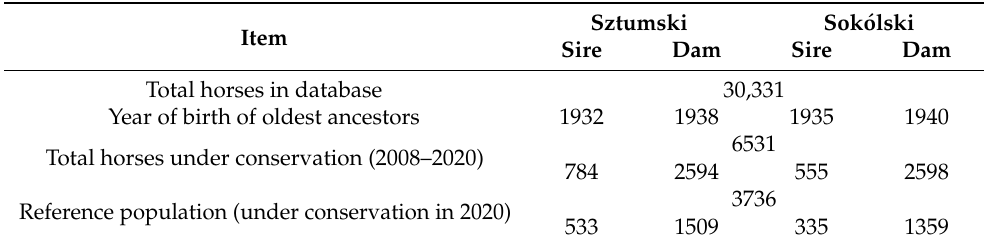
Table 1. The pedigree data of the number of Sztumski and Sok ó lski horses participating in genetic resources conservation programs from 2008 to